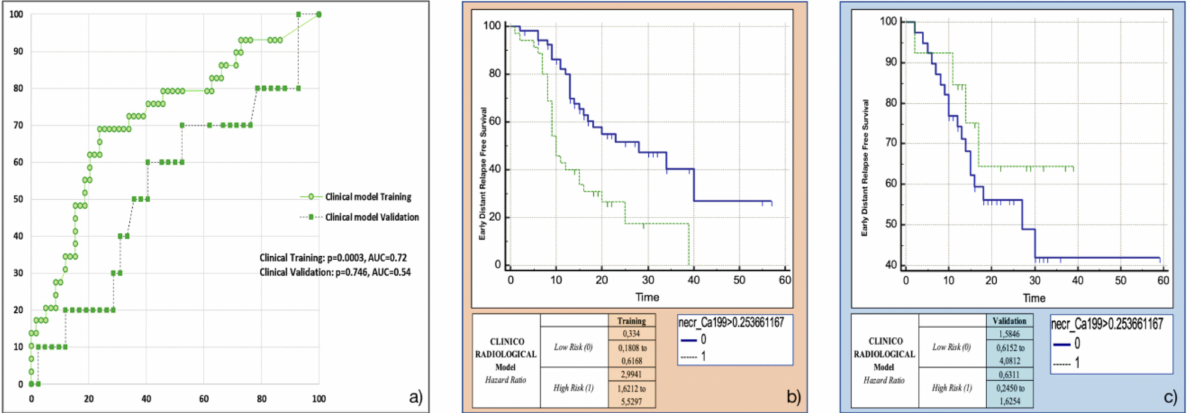
Figure 5. Clinicoradiological model overall performance in terms of ( a ) area under the ROC curve (AUC) for both training (green empty circles) and validation (green filled squares) cohorts, and outcome prediction in terms of Kaplan Meier curve separation between low and high risk patients according to the computed prognostic index in both training ( b ) and validation ( c )